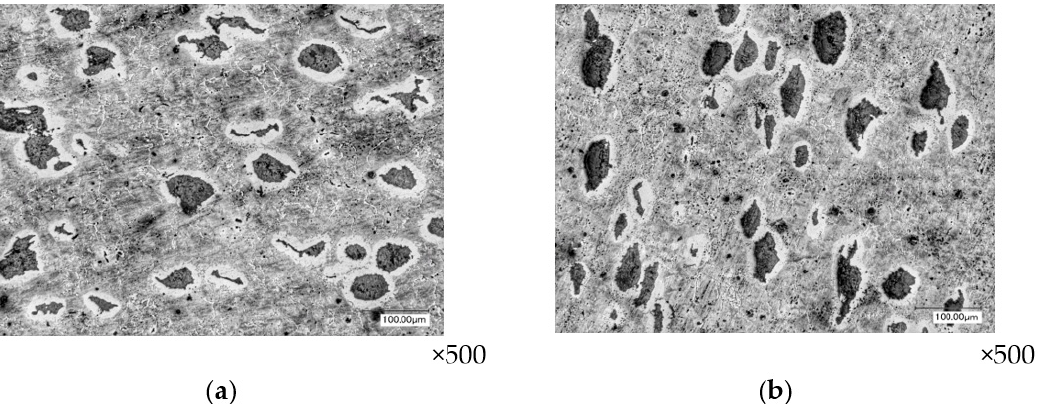
Figure 9. The shape of graphite inclusions in the end layers of the pipe forging section (layer № 7): layered section ( a ) and end section ( b ).